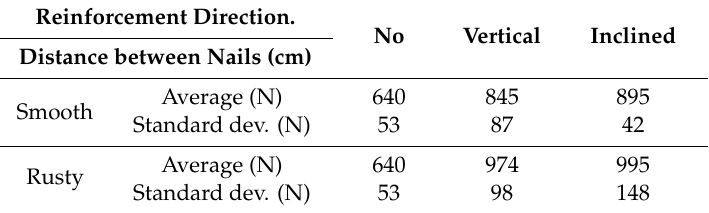
Table3. Maximumbendingforcerecordedforsamplewithbendingforceparalleltothelayer’sdirection. Reinforcement